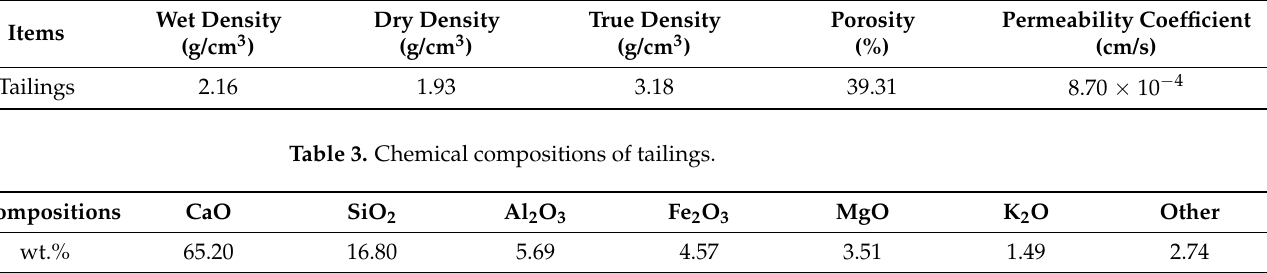
Figure 5. Particle size distribution of tailings.